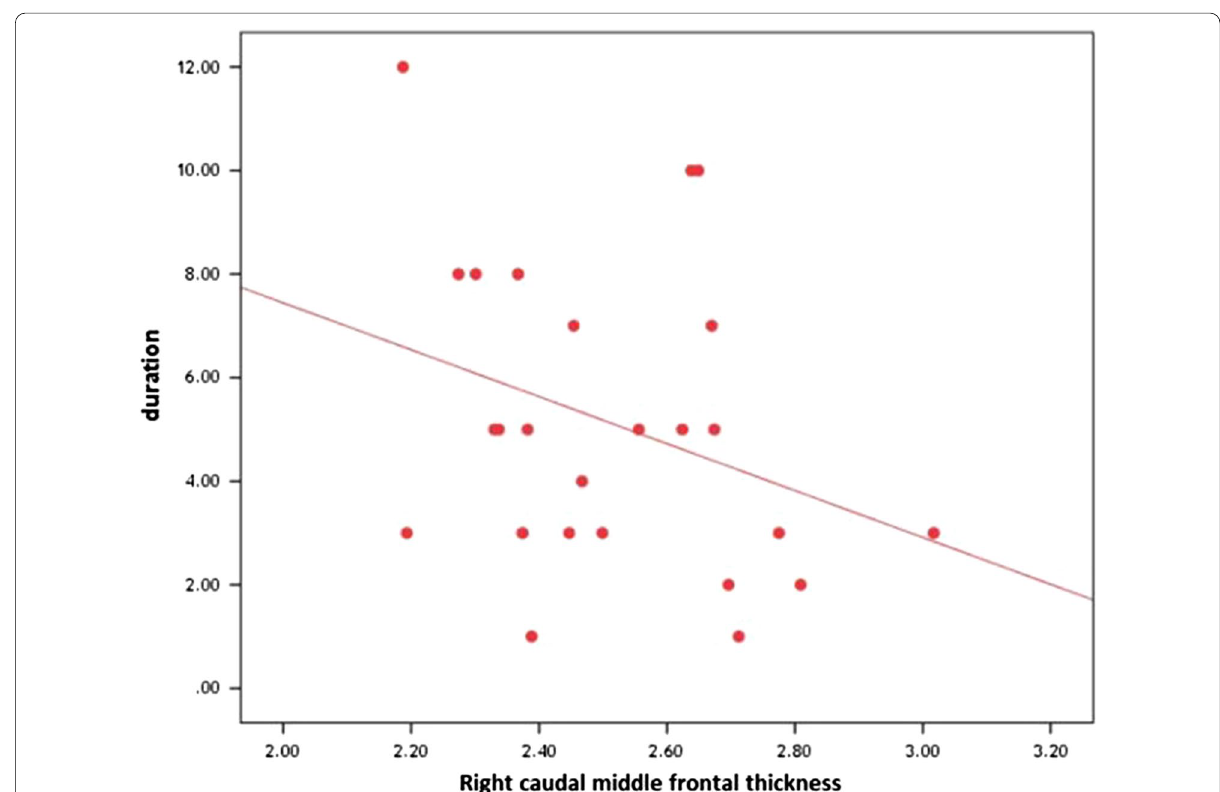
Fig. 4 Significant negative correlation between the disease duration and right caudal middle frontal